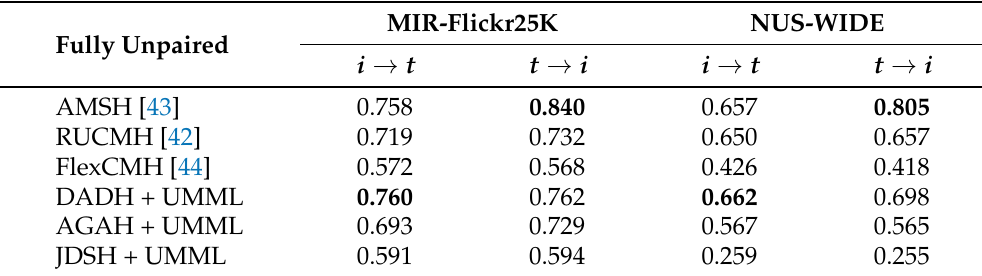
Table 8. Fully unpaired 64-Bit mAP evaluation results for unpaired CMH methods and traditional CMH methods using